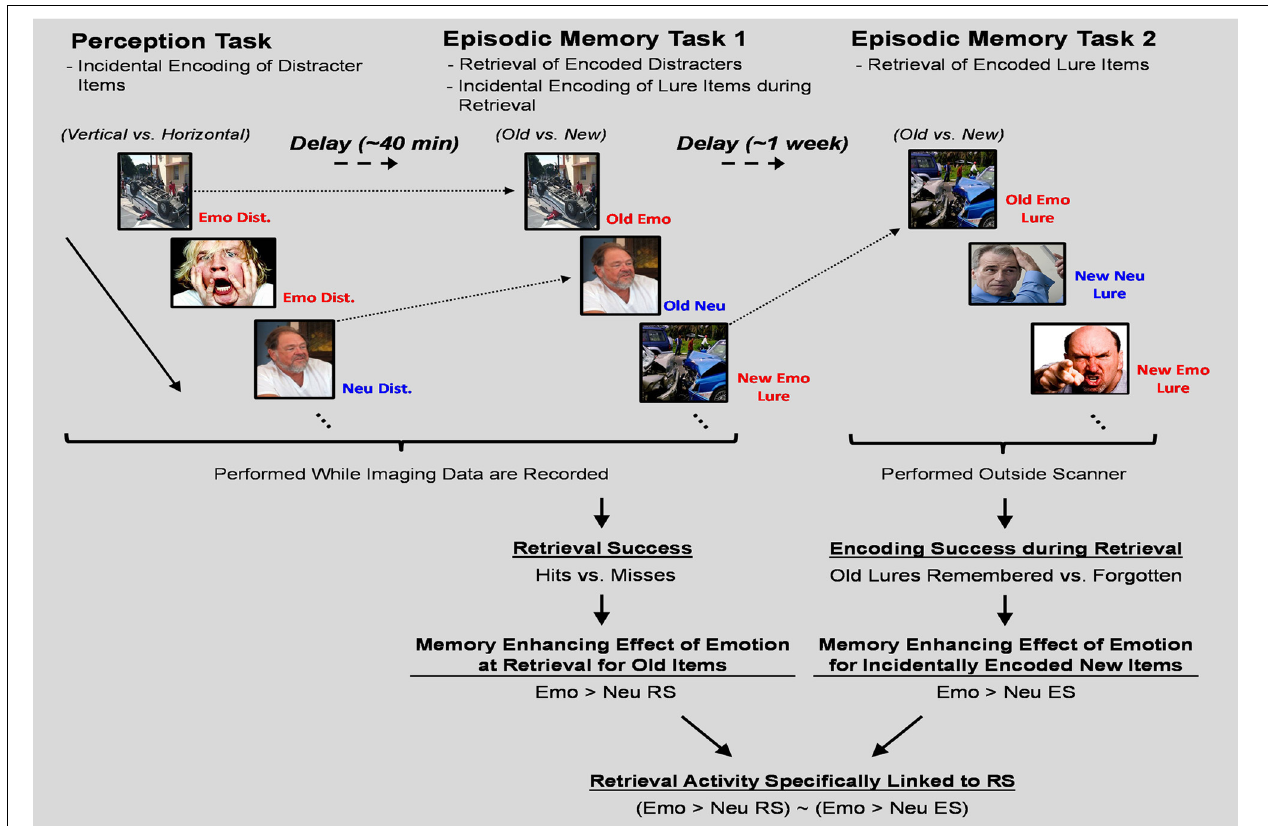
FIGURE 1 | Diagram of the experimental paradigm. A novel experimental paradigm was implemented to investigate the relationship between retrieval success activity and incidental encoding success activity during retrieval. The perception task required participants to determine the orientation of vertically or horizontally presented pictures with emotional, neutral, or no distraction. Immediately following completion of the perception task, memory for a subset of the pictures presented as distracters during the task was tested in a surprise episodic memory task (EM-1). EM-1 allowed for the examination of the neural correlates of retrieval success of the distracter items incidentally encoded during the perception task, and also served as the “study” phase for emotional and